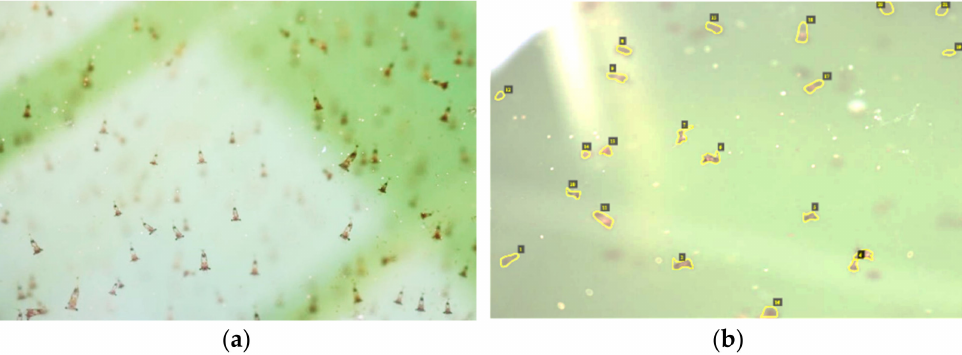
Figure 6. ( a ) Underwater image detection for shrimp, and ( b ) example of a labeled